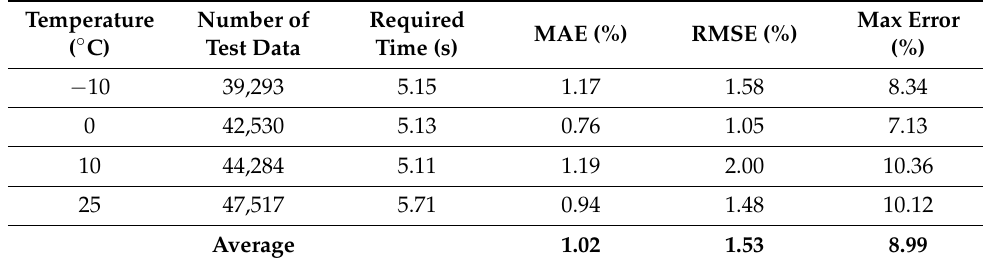
Figure 12. Performance of the CNN bi-directional-LSTM model at − 10 ◦ C ( a ) measured and predicted SOC values and ( b ) absolute errors from the test data. Table 5. Test results of the GRU